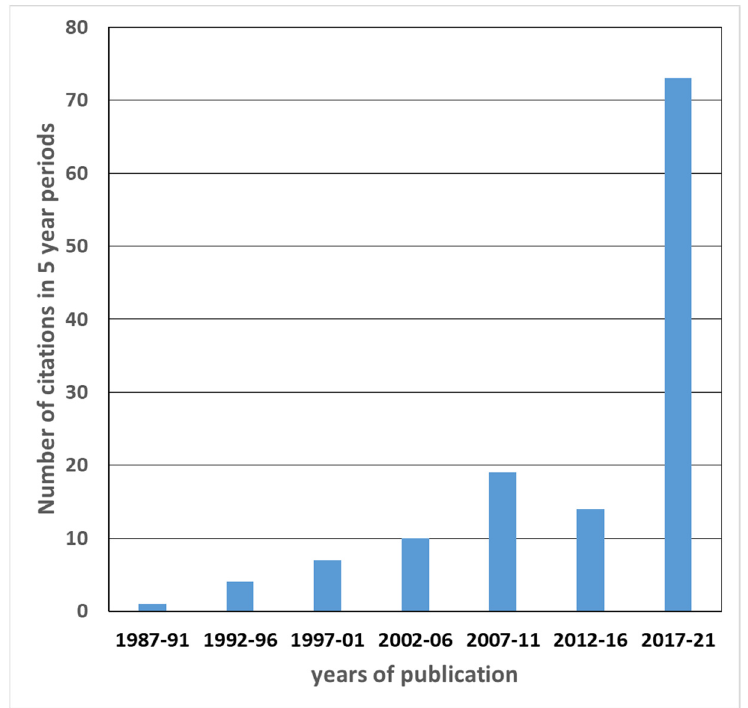
Figure 3. Distribution of 128 titles cited between 1987 and 2021 in 5-year periods.